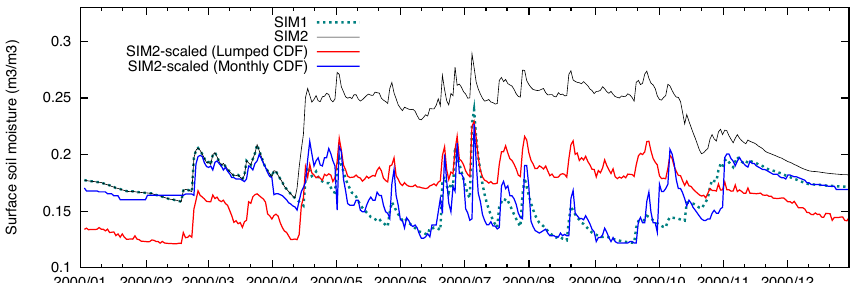
Figure 7. Same as Fig. 2 and including the surface soil moisture time series from rescaling SIM2 to the SIM1 climatology. The red and blue lines represent the SIM2 integration rescaled to the SIM1 climatology using lumped and monthly CDF matching,